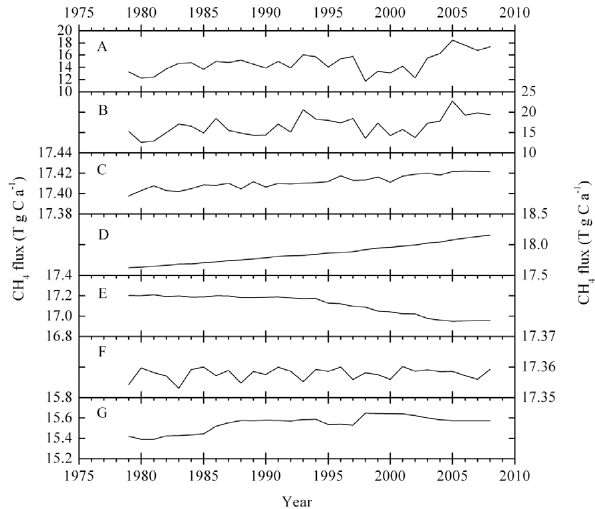
Fig. 5 . Temporal variations of terrestrial CH 4 flux caused by global change factors over North 2 Fig. 5. Temporal variations of terrestrial CH 4 flux caused by global America from 1979 to 2008 (A: all combined simulation; B: climate only simulation; C: N 3 change factors over North America from 1979 to 2008 ( (A) : all deposition only simulation; D: CO 2 only simulation; E: O 3 only simulation; F: N fertilizer 4 application simulation; G: land conversion only simulation) 5 combined simulation; (B) : climate only simulation; (C) : N deposi- tion only simulation; (D) : CO 2 only simulation; (E) : O 3 only simu- lation; (F) : N fertilizer application simulation; (G) : land conversion only